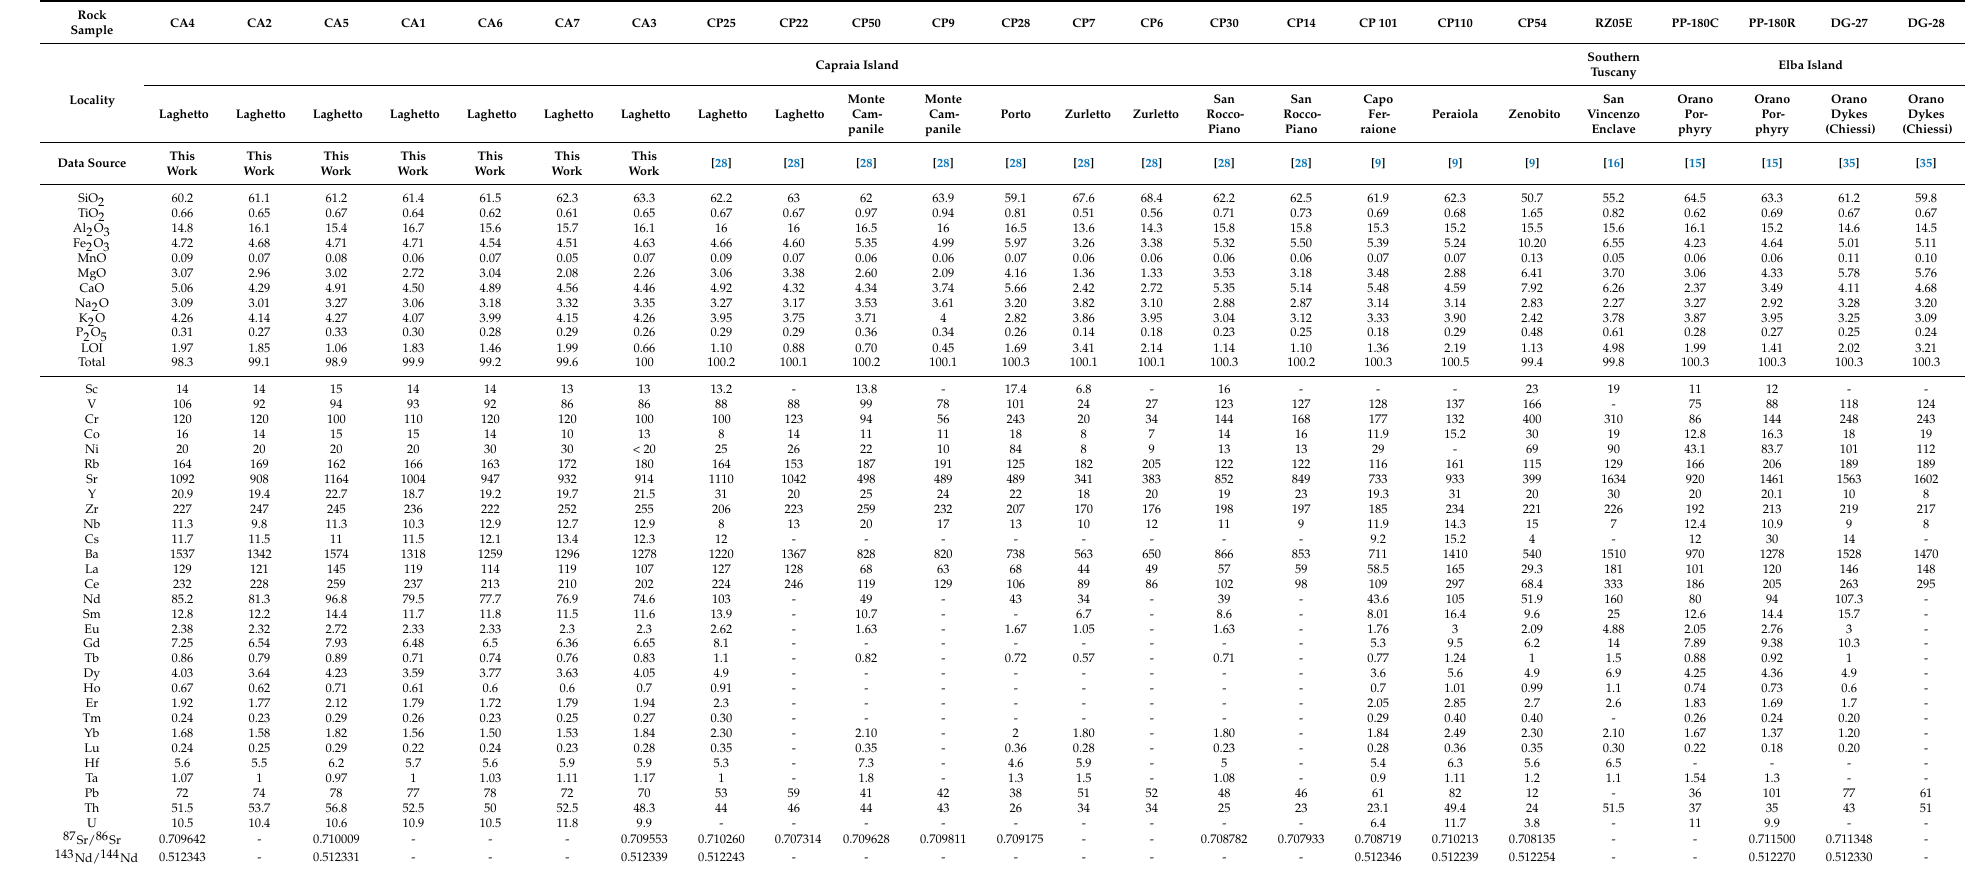
Table 2. Major (%), trace (ppm) and isotopic compositions of representative rocks from Capraia